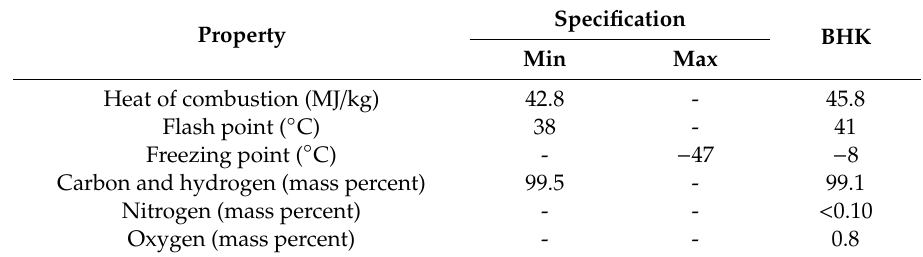
Table 5. The physical and chemical properties of bio-hydrogenated kerosene (BHK) produced